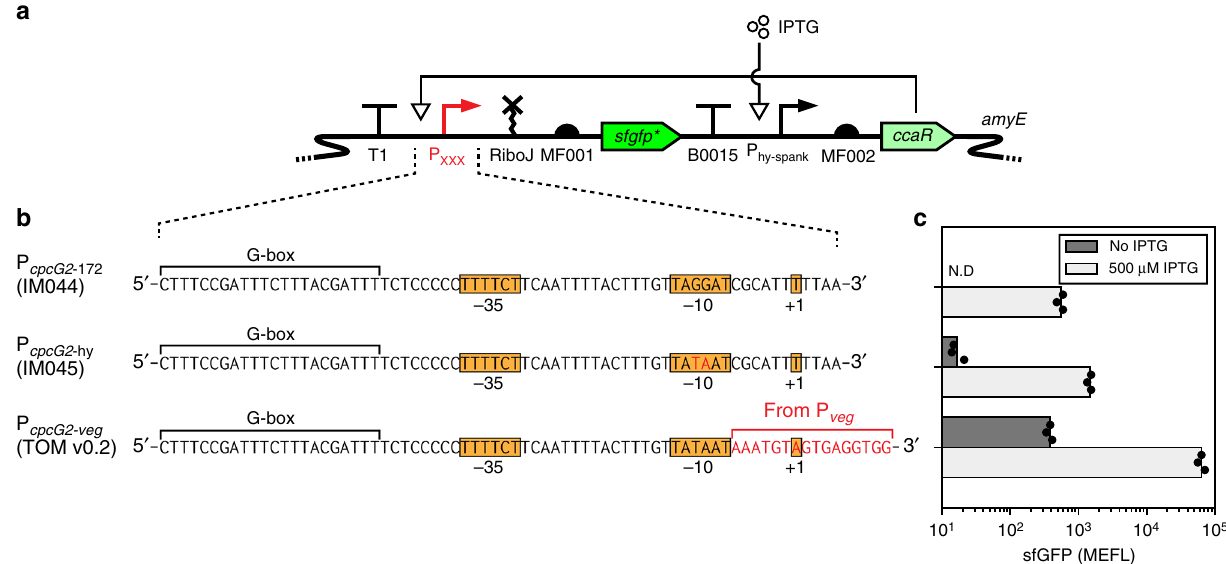
Fig. 4 Optimization of the transcriptional output module. a Characterization of P cpcG2 -172 and subsequently-engineered variants using a standard promoter characterization cassette. The promoters are inserted downstream of a transcriptional terminator to prevent any read-through transcription from the amyE locus, and drive transcription of an mRNA containing the self-cleaving ribozyme RiboJ 48 , MF001, and sfgfp with the fi rst 15 codons optimized ( sfgfp* ) (see